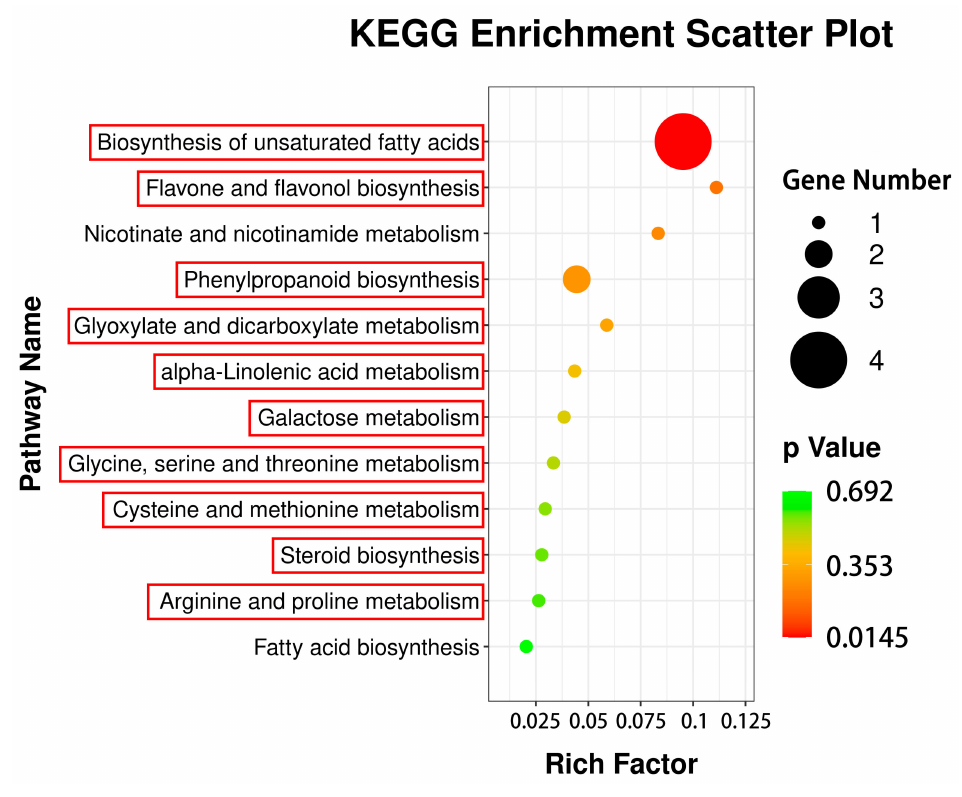
Figure 2. KEGG annotation of DAMs.